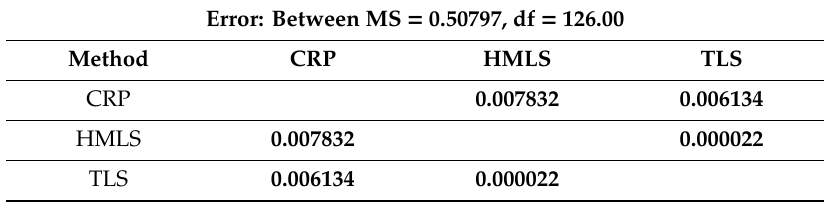
Table A1. Results of one-way ANOVA post hoc Tukey HSD test for di ff erent methods of DBH estimation. Error: Between MS = 0.50797, df = 126.00